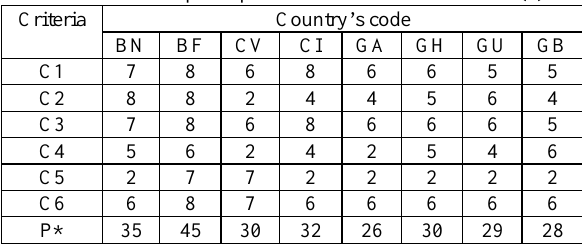
Table 2a. : Geospatial performance of Member States (1) Criteria